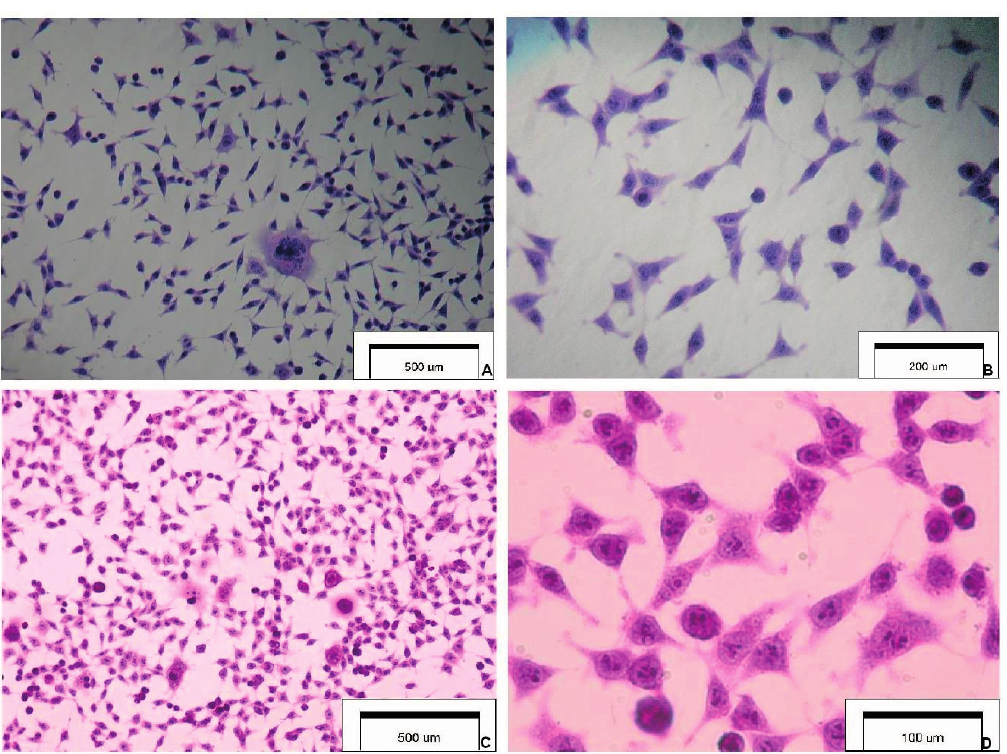
Figure 1. Cytology and morphology of investigated SCC-25 carcinoma cells. Hematoxylin & eosin staining (optical magnification ×100, ×400, ×600). The main cytological features: ( A ) highly irregular shaped cells (tadpole, caudate), irregular nuclear shapes, multinuclear large cell; ( B ) elongated cells, coarse dense chromatin, cells with an increased nucleus:cytoplasm ratio and a malignant-looking nucleus; ( C ) pleomorphism, nuclear enlargement, single giant cells, cells maintaining cohesiveness; and ( D ) cytoplasmic density, chromatin granularity, hyperchromasia, prominent